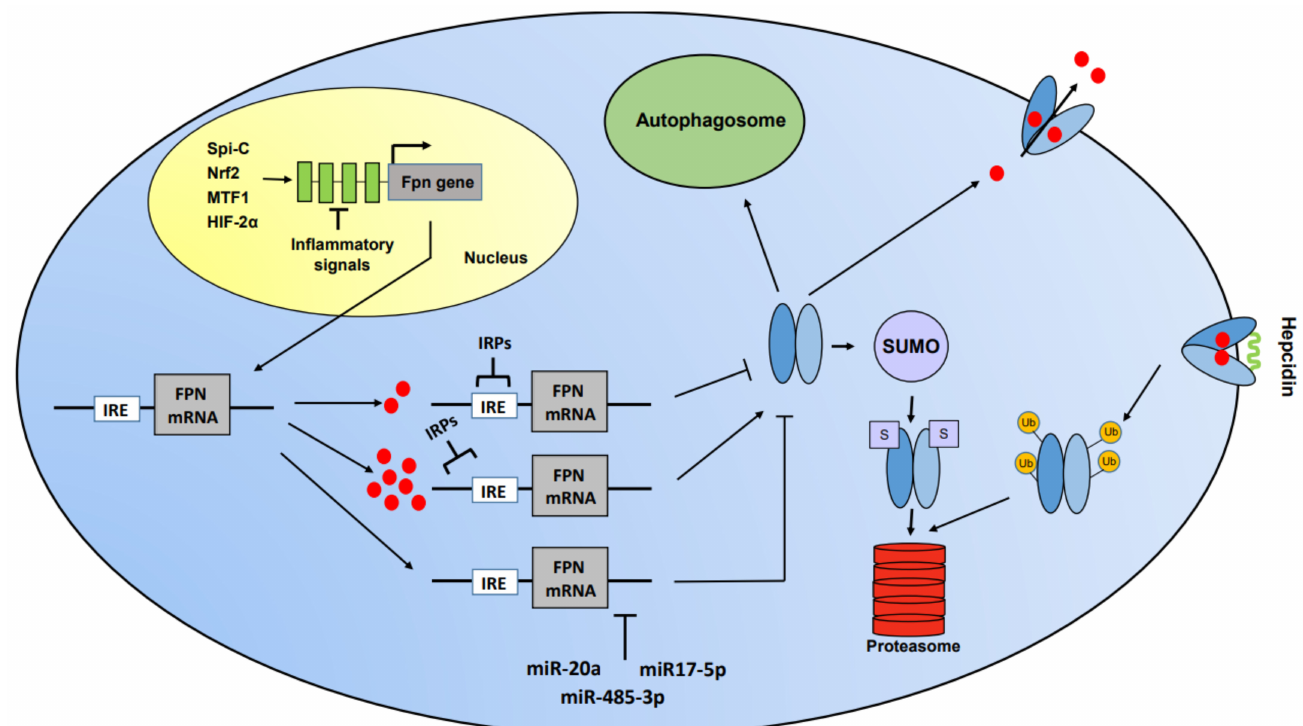
Figure 1. Multilevel regulation of ferroportin (FPN) expression. Transcriptional control: the transcription factors Spic, Nrf2, MTF1 and HIF-2 α activate ferroportin transcription whereas still unknown factors responding to inflammatory signals inhibit FPN transcription. Post-transcriptional control: under conditions of iron deficiency, active iron regulatory proteins (IRPs) bind the iron regulatory element (IRE) in the 5 (cid:48) end of FPN mRNA, thereby blocking its translation. The 3 (cid:48) end of FPN mRNA is targeted by miRNAs which prevent FPN expression. Post-translational level: in the cytoplasm, FPN can be targeted to the autophagosome or, upon sumoylation, to the proteasome. At the cell surface, where FPN releases iron in the extracellular space or the bloodstream, hepcidin blocks iron transport through the pore and results in the internalization, ubiquitination and proteasomal degradation of